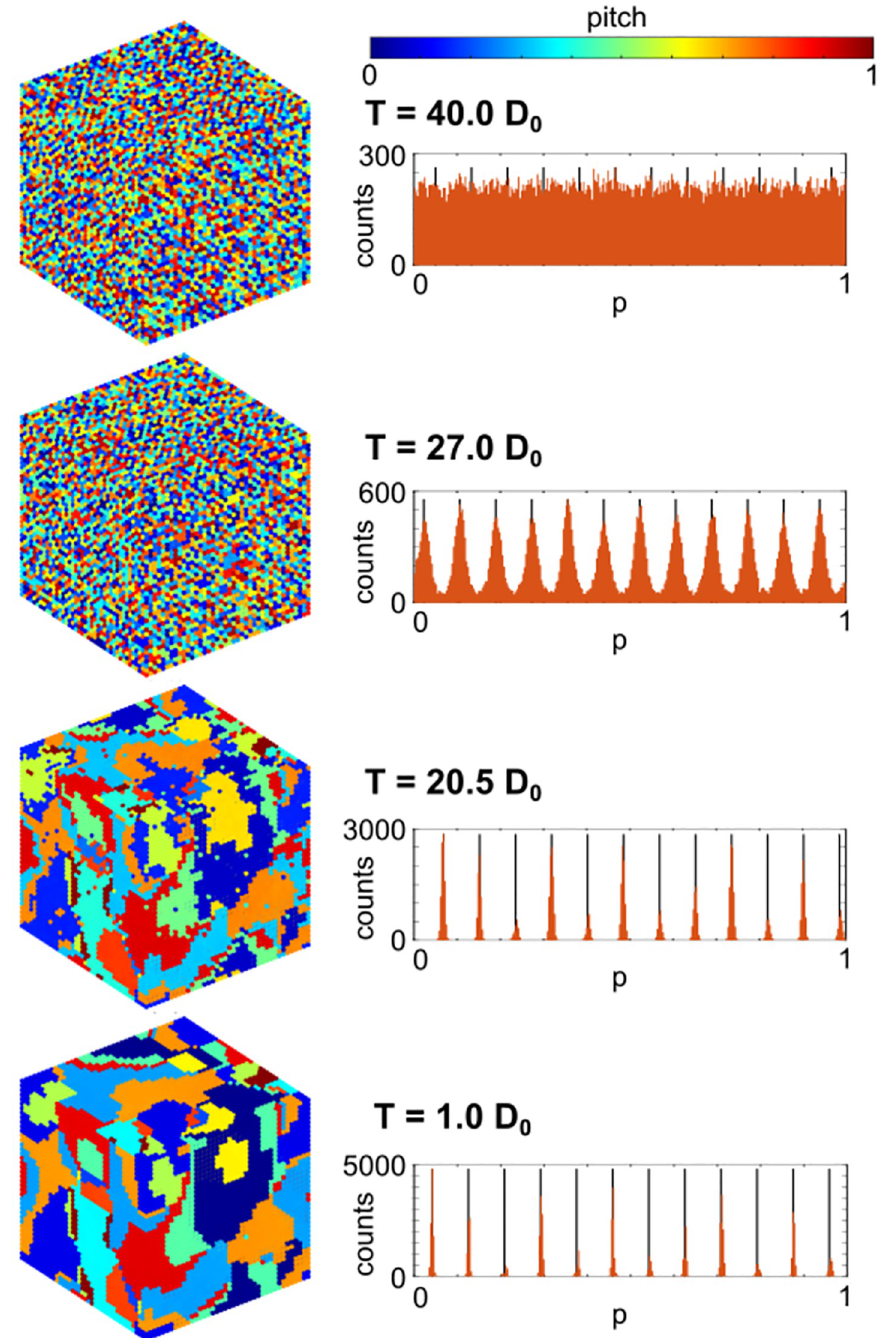
Fig 2. Typical simulation results. Right: Histograms of pitches p over one octave on the simulated lattice, as temperature is quenched at τ Q = 3276 t 0 from above T c at T = 40 D 0 to near T c � 27 D 0 , and then towards T = 0. The illustrated by the 12 equally spaced black lines. Left: 12-fold octave division used in Western music emerges near T = T c Simulated lattice of tones at the same simulation steps shown at right. Domains of nearly constant pitch emerge at low temperature, separated by discrete domain walls.